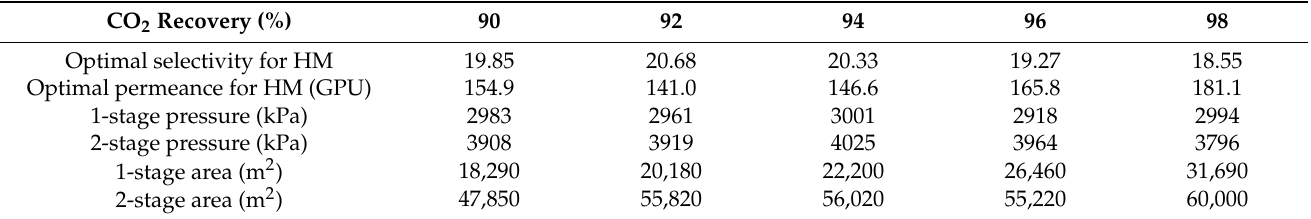
Table 4. Information on the optimal process of increasing CO 2 recovery when the H 2 -selective membrane changes based on the Robeson upper bound.